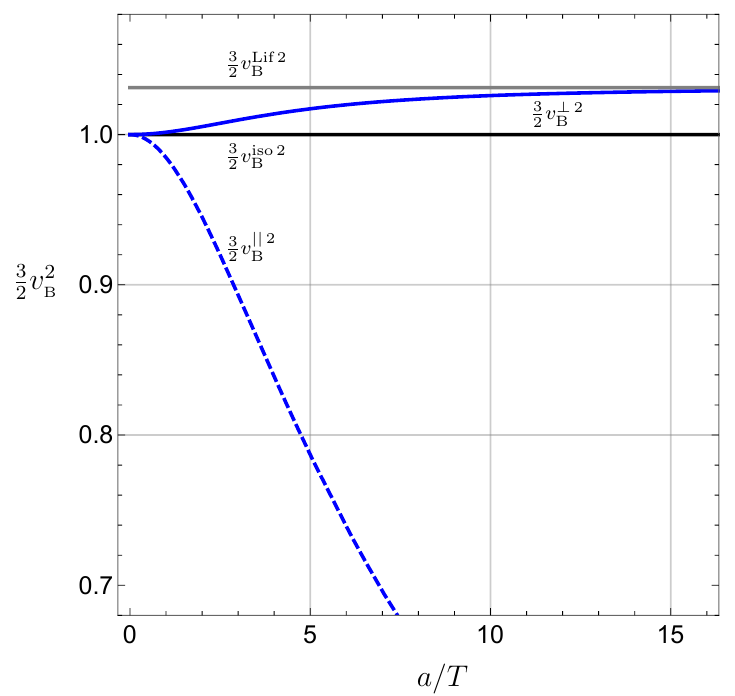
v jj 2 . The black B 2